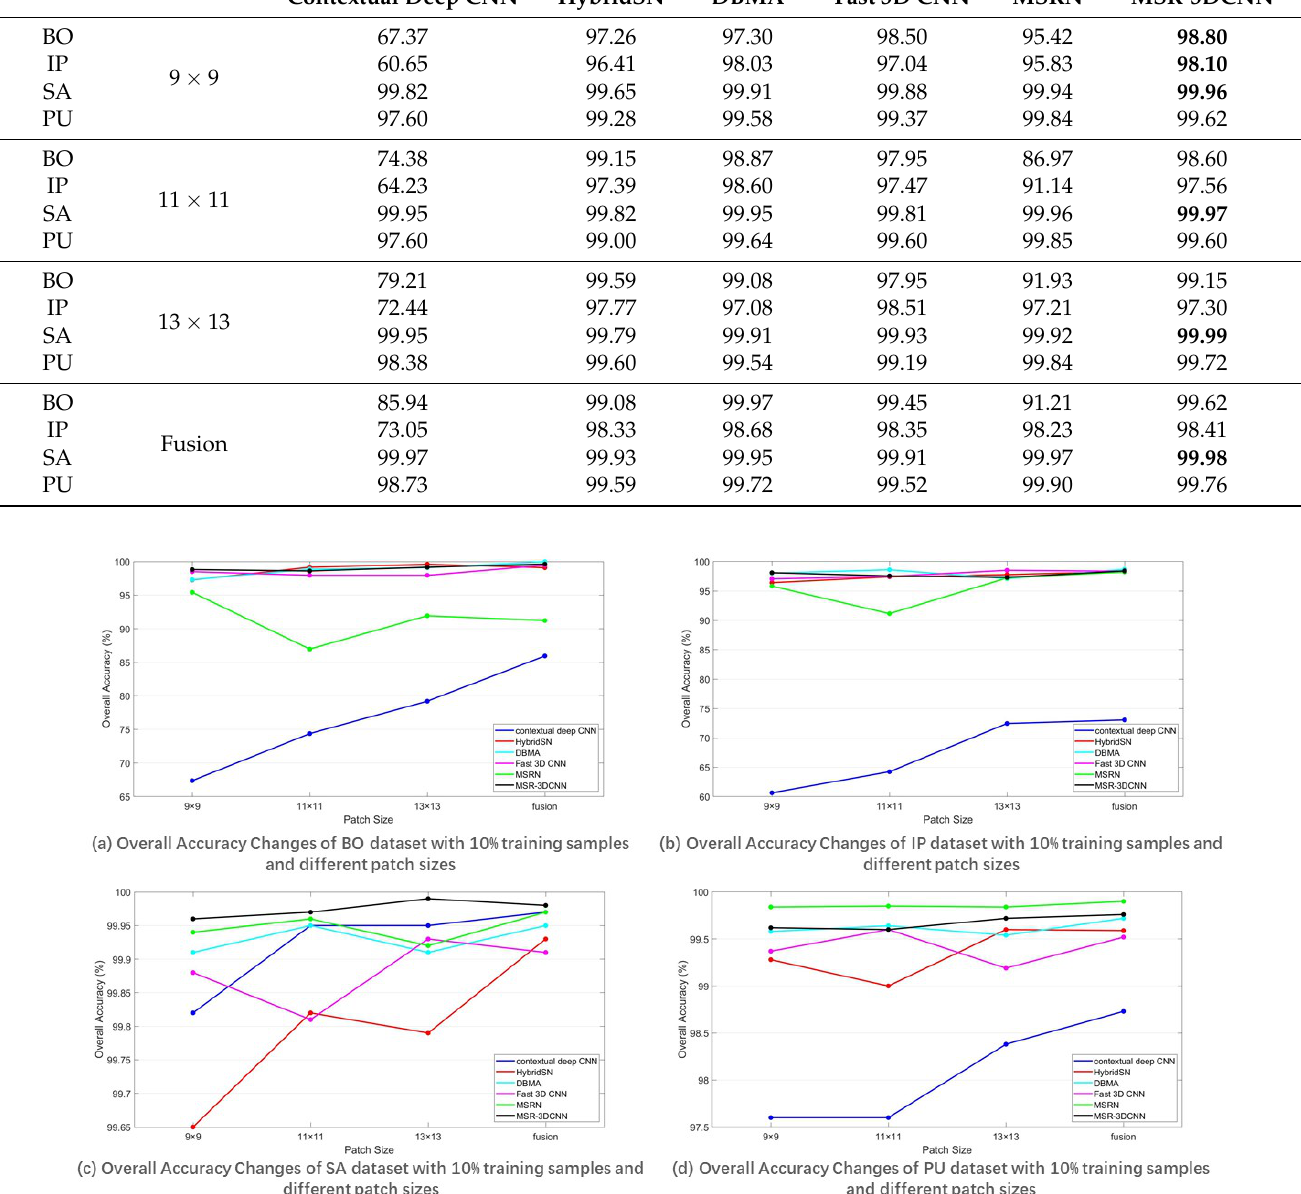
Figure 9. Changes of the overall accuracy of predictions on the four datasets, using 10% samples for training and different patch